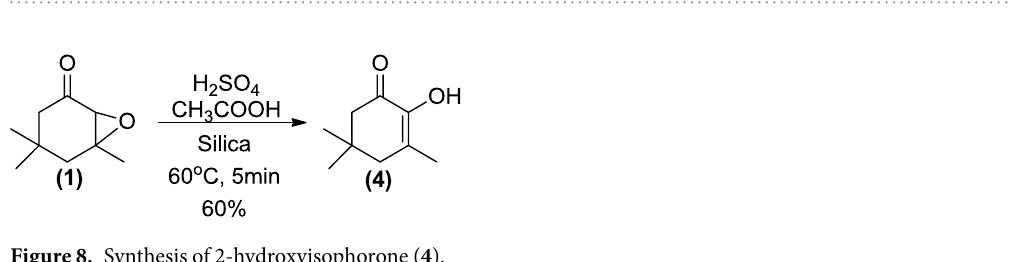
Figure 7. Comparison between the GC profiles of the racemate cis - 3 , (1 S ,2 S ,6 R )- 3 , (1 R ,2 R ,6 S )- 3 , the natural extract, and the coinjection of the racemate and the natural extract on a β -DEX 325 ® capillary column.